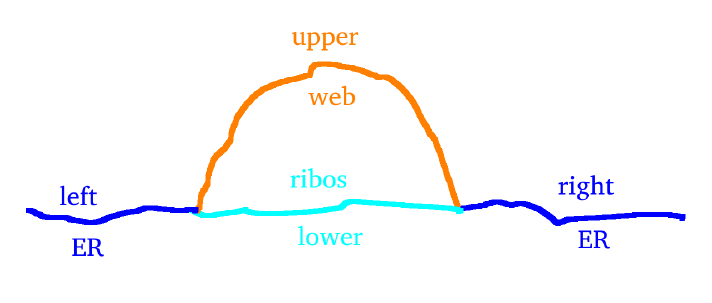
Figure 4. Schematic description of the four different sub paths around the web, as shown in Figure 3 (cf. Section 2.10). The ordering of the sub paths shown in this figure corresponds to the perspective as shown in the realistic geometry screenshot in Figure